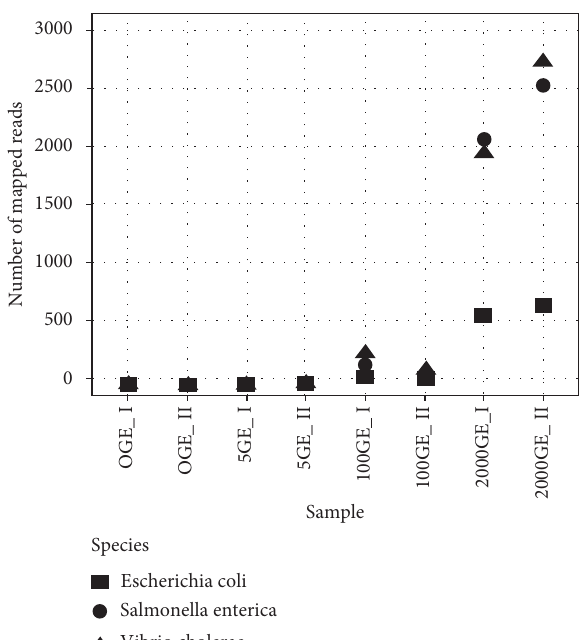
Figure 4: Number of mapped reads for target bacterial species in a human DNA background sample sequenced in Ion Torrent PGM. Alignment was produced using the 16S rRNA consensus gene of the three species Escherichia coli , Salmonella enterica , and Vibrio cholera using Bowtie2. Different GE concentrations are in duplicate. 0GE_I and II; 5GE_I and II; 100 GE_I and II; 2,000GE_I and